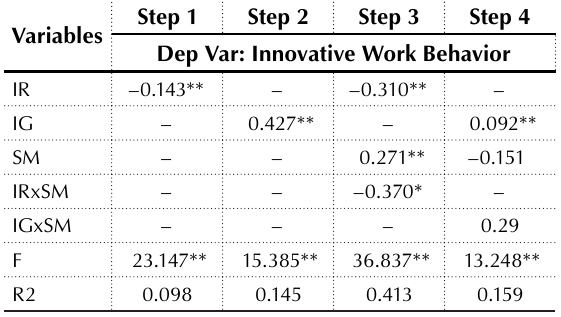
Table 3. Regression result predicting